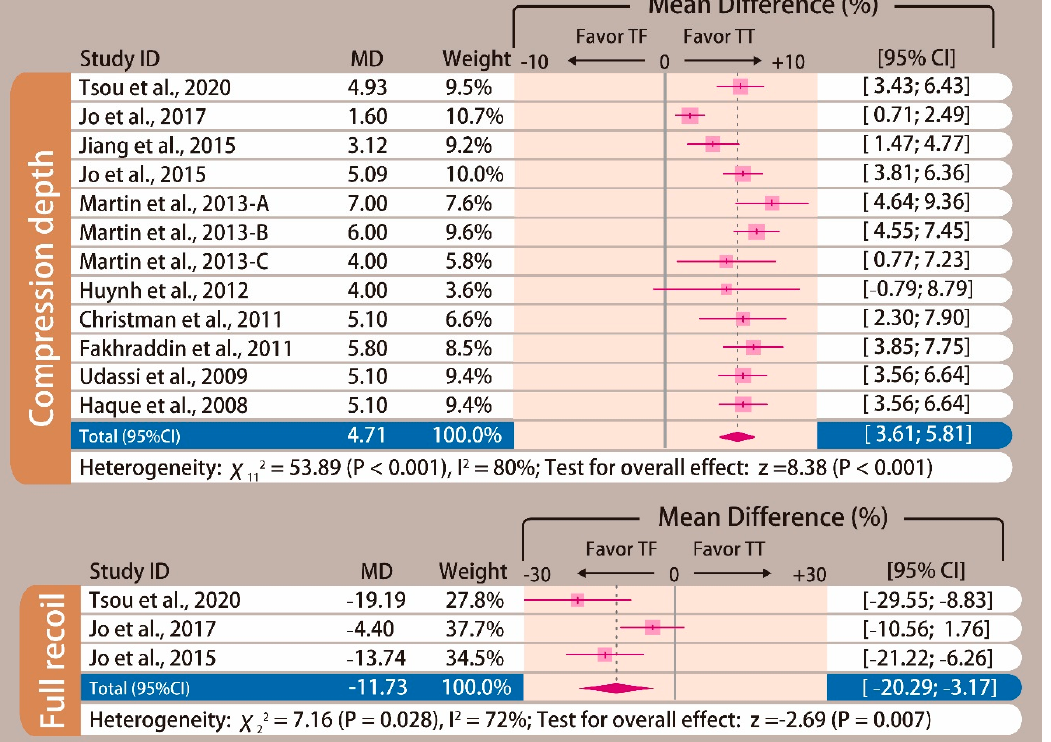
Figure 4. Forest plot of chest-compression depth and proportion of complete chest recoil.